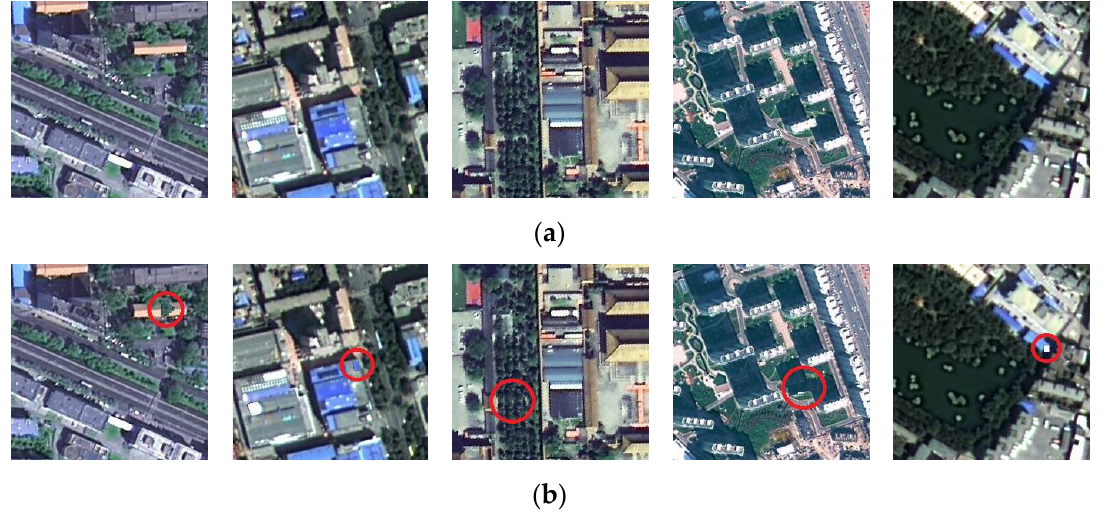
Figure 1. Examples of tampered HRRS images: ( a ) Original HRRS images, ( b ) tampered images, and the tampering operations (from left to right) are: a building is modified, a building is added, a tree is added, a building is deleted, and random malicious cut-out is performed.